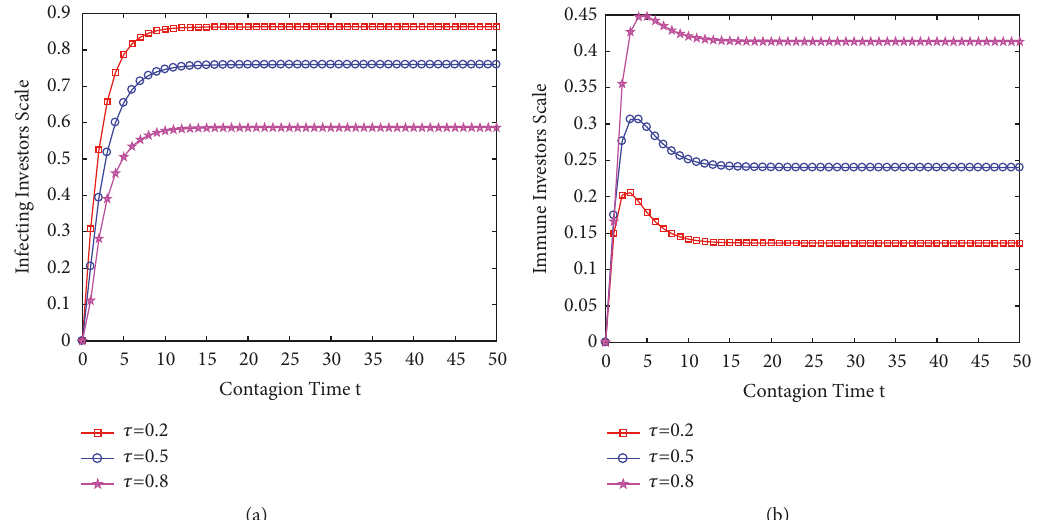
Figure 9: Changes in the scale of infecting investors and immune investors with the contagion time under different investor risk cognitive level 𝜏 .